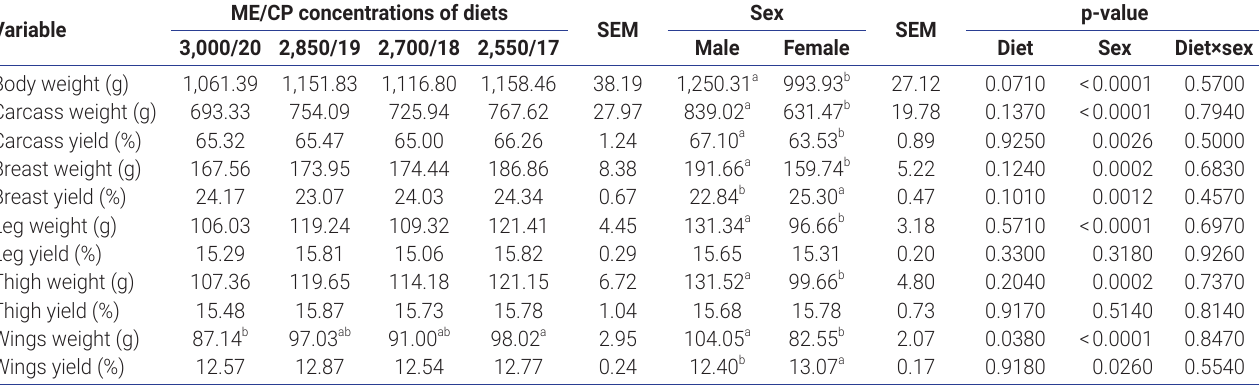
Table 3. Carcass yield of 12-week-old of Mexican Creole chickens fed diets with different concentrations of ME and CP